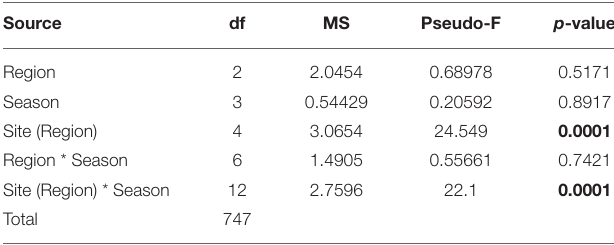
TABLE 4 | Results from PERMANOVA tests comparing mean coral recruits densities among regions, sites and seasons. Source df MS Pseudo-F p -value Region 2 2.0454 0.68978 0.5171 Season 3 0.54429 0.20592